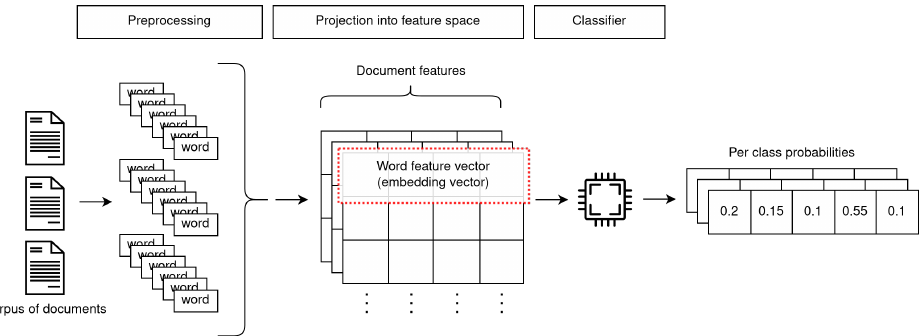
Figure 1. An overview of the two-step procedure adopted by shallow learning